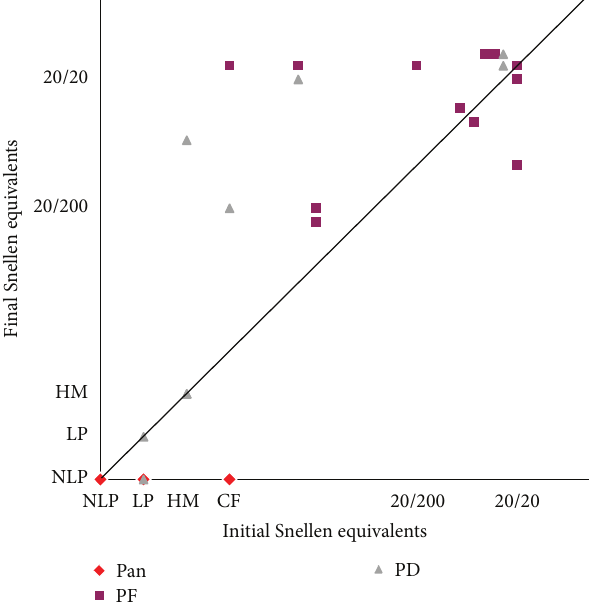
Figure 1: Visual outcome of endogenous bacterial endophthalmitis. CF, counting fingers; HM, hand motion; LP, light perception; NLP, no light perception (including enucleation); Pan, panophthalmitis; PD, posterior diffuse; PF, posterior